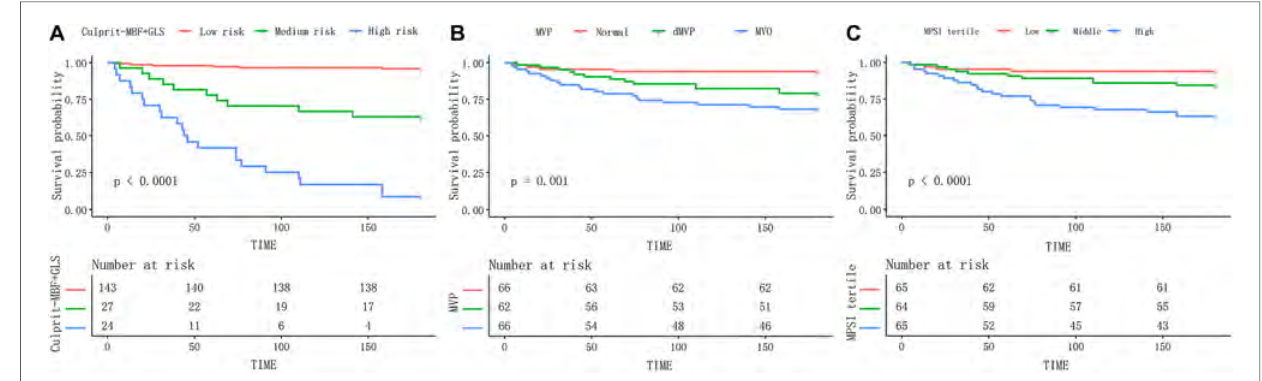
FIGURE 5 The Kaplan – Meier curves of different models during 6-month follow-up. The proposed risk strati fi cation ( A ) exhibits better discrimination than the MVP ( B ) and MPSI ( C ) models. MBF, microvascular blood fl ow; MVP, microvascular perfusion; MPSI, myocardial perfusion score